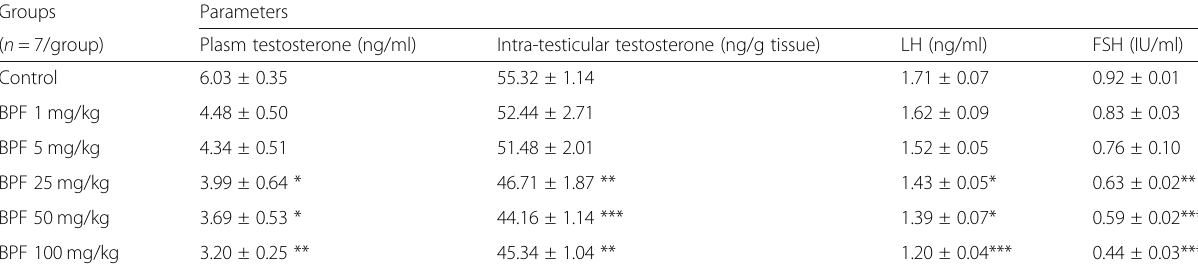
Table 3 Subchronic effect of Bisphenol F (BPF) on the intra-testicular testosterone, plasma testosterone, luteinizing hormone (LH), and follicle-stimulating hormone (FSH) production in